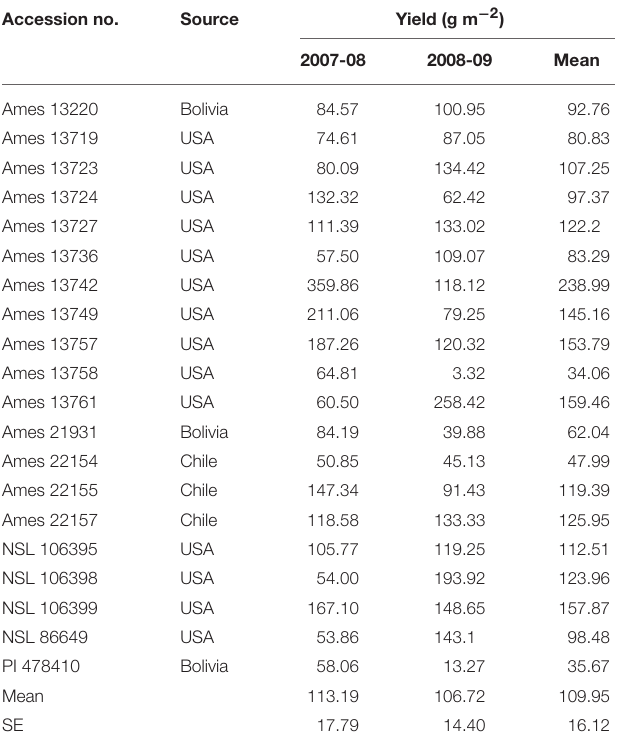
TABLE 1 | Grain yields in 20 selected quinoa accessions grown in winter 2007-08 and 2008-09 (source: Rao and Shahid, 2012). Accession no.